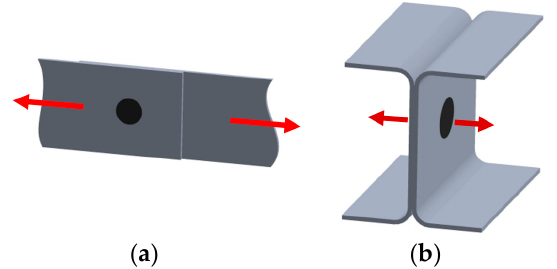
Figure 5. Shape of the spot welded joint for determining the characteristics of the specimens: for the shear force ( a ); for the axial force ( b ).